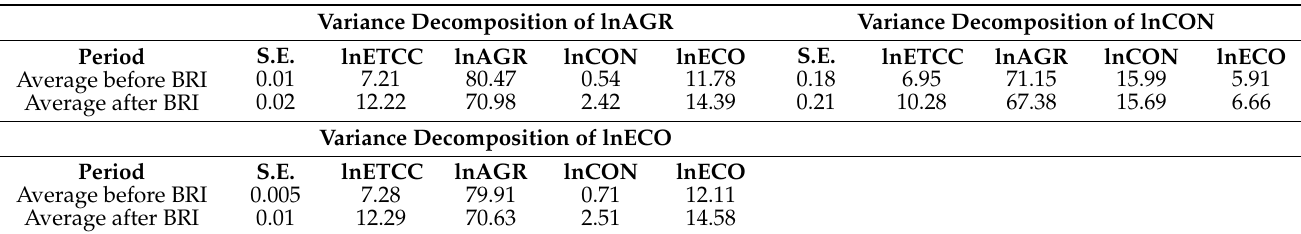
Table 7. Variance decomposition results of lnTRA, lnAGR, lnCON, and lnECO. Variance Decomposition of lnAGR Variance Decomposition of lnCON